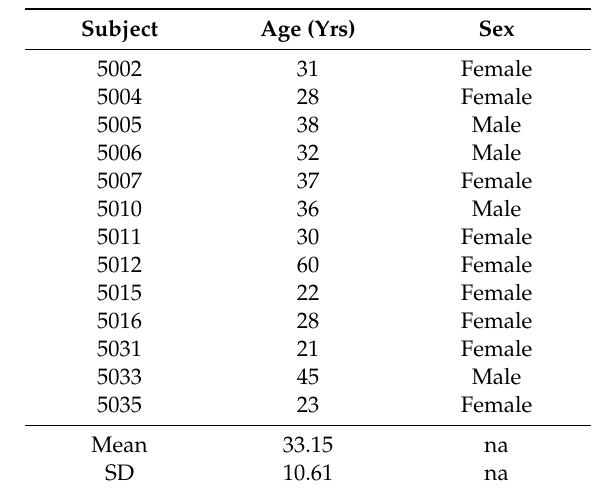
Table 1. Demographic results for the respective subjects.